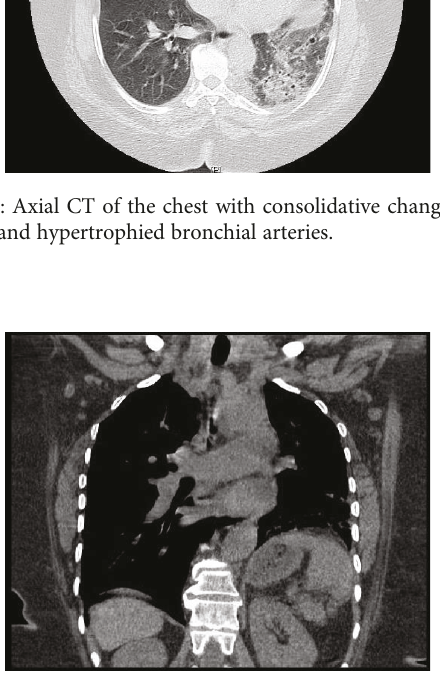
Figure 2: Coronal CT chest demonstrated marked enlargement of the right pulmonary artery with absence of the left pulmonary artery.